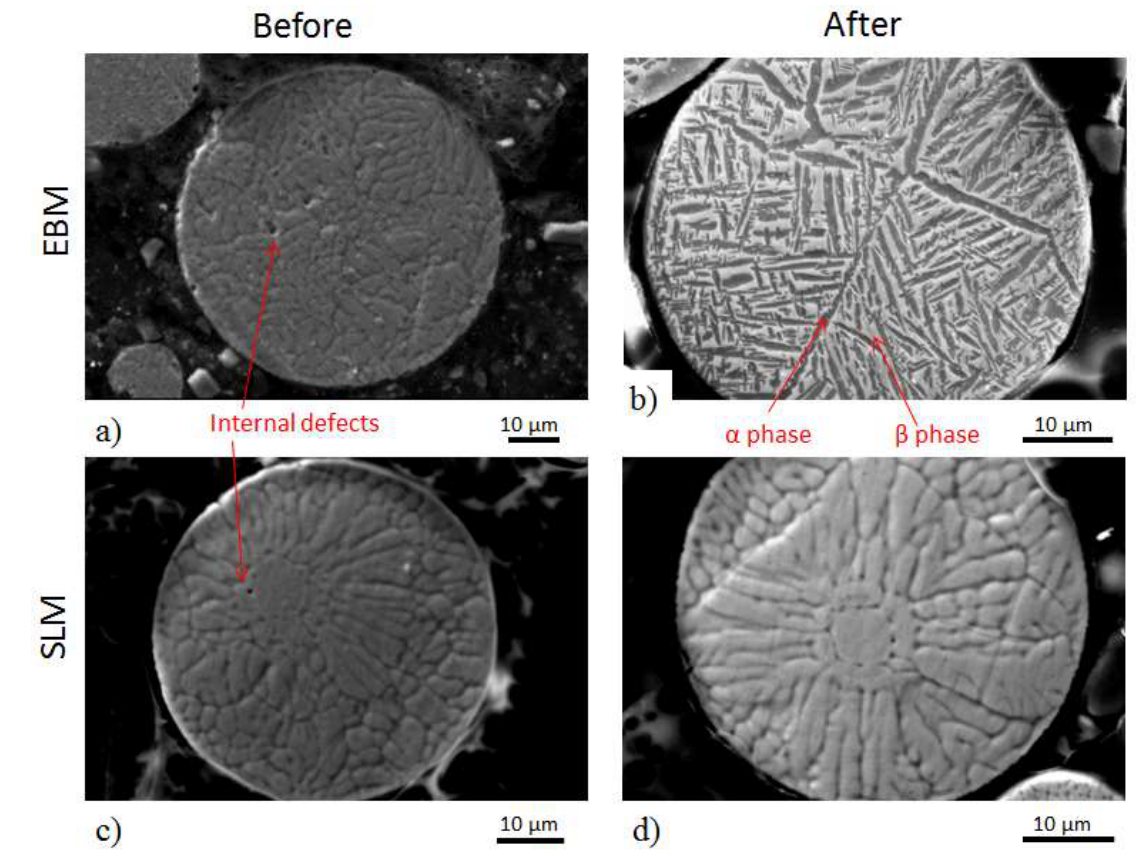
Figure 3. Internal microstructure of EBM powder ( a ) before and ( b ) after processing. Microstructure of SLM powder ( c ) before and ( d ) after processing.